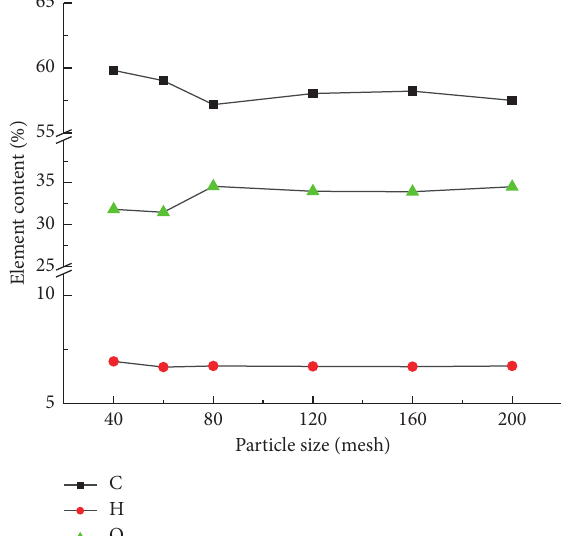
Figure 8: Element content changes of phenolic resin before and after crushing.